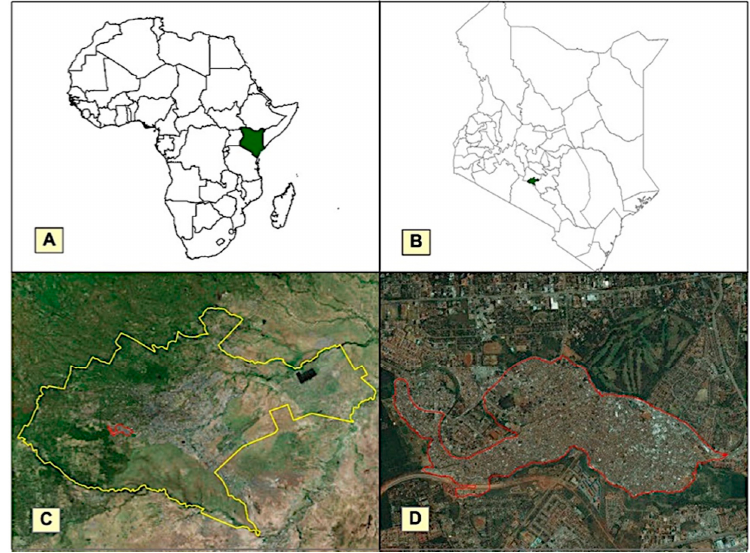
Figure 6. Map showing the location of ( A ) Kenya relative to Africa; ( B ) Nairobi relative to Kenya; ( C ) the Kibera slum relative to Nairobi and ( D ) the Kibera slum (background imagery source: ESRI [189]).